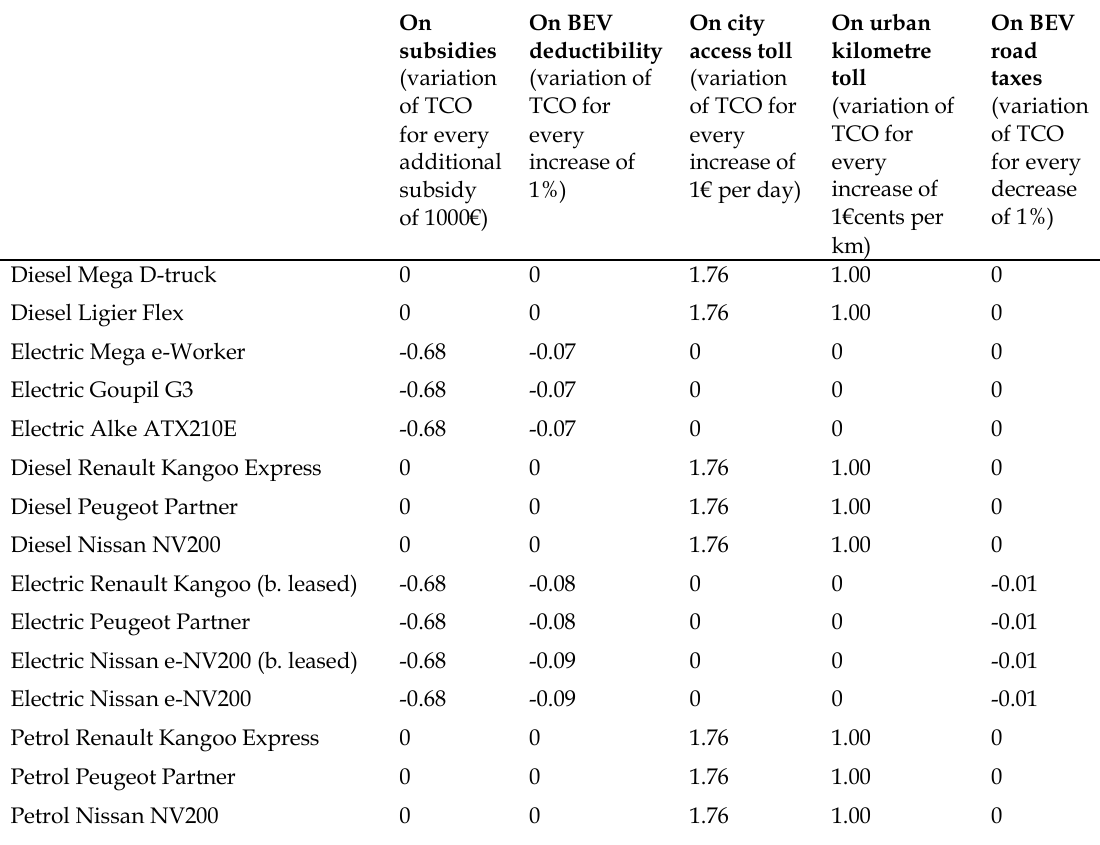
Table 3. Sensitivity analysis of TCO results on the level of subsidies, BEV deductibility, city access toll, urban kilometre toll and road